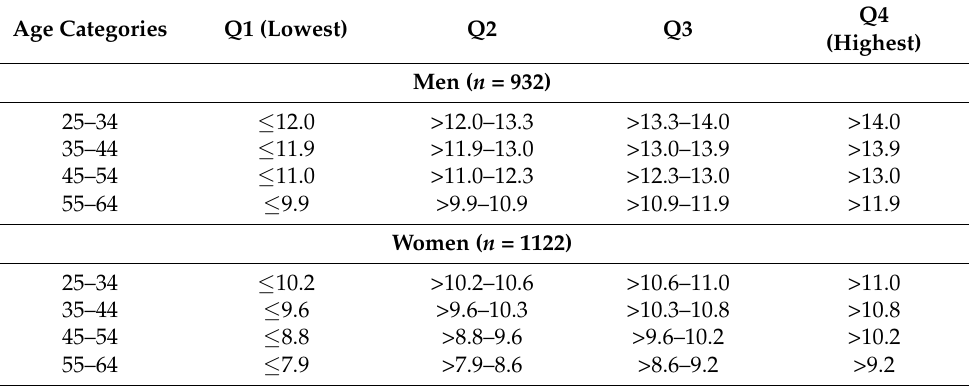
Table 2. Cardiorespiratory fitness classification (METs) according to quartiles of fitness (n = 2054).